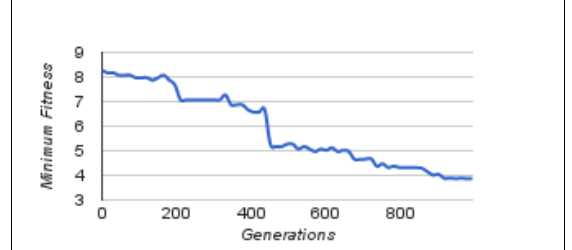
Figure 6: Optimization results (Lower values are better)